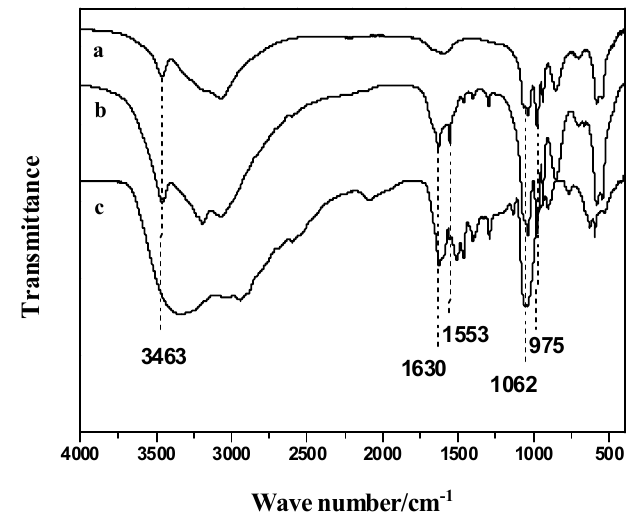
Figure 2. FTIR spectrum of the nanoflower (curve b) and its raw materials (curve a, cobalt phosphate; and curve c, DPEase).